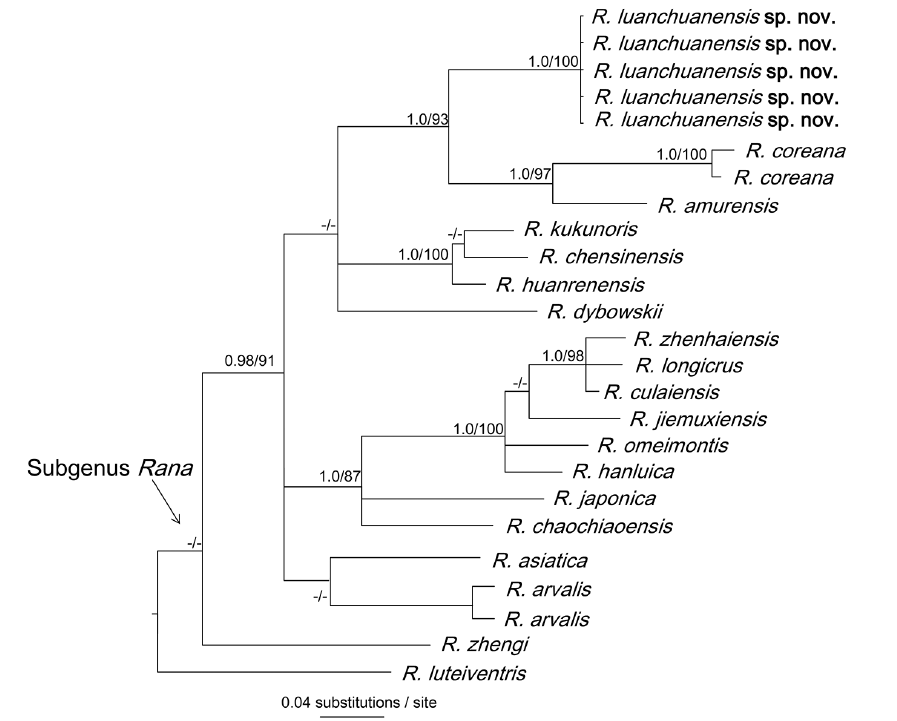
Figure 2. A Bayesian inference tree based on the COI partial sequence data. Numbers near the nodes are Bayesian posterior probabilities / ML bootstrap value but only when values are ≥ 0.95 and ≥ 70,